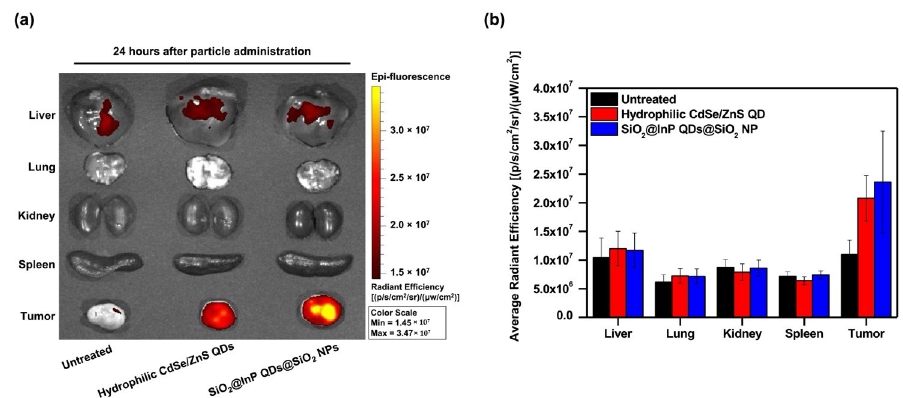
Figure 4. In vivo biodistribution of SiO 2 @InP QDs@SiO 2 NPs. ( a ) Comparison of biodistribution and fluorescence of particles in major organs and tumors after administration of SiO 2 @InP QDs@SiO 2 NPs and hydrophilic CdSe/ZnS QDs to tumor syngeneic mice. ( b ) Comparison of average radiant efficiency in major organs and